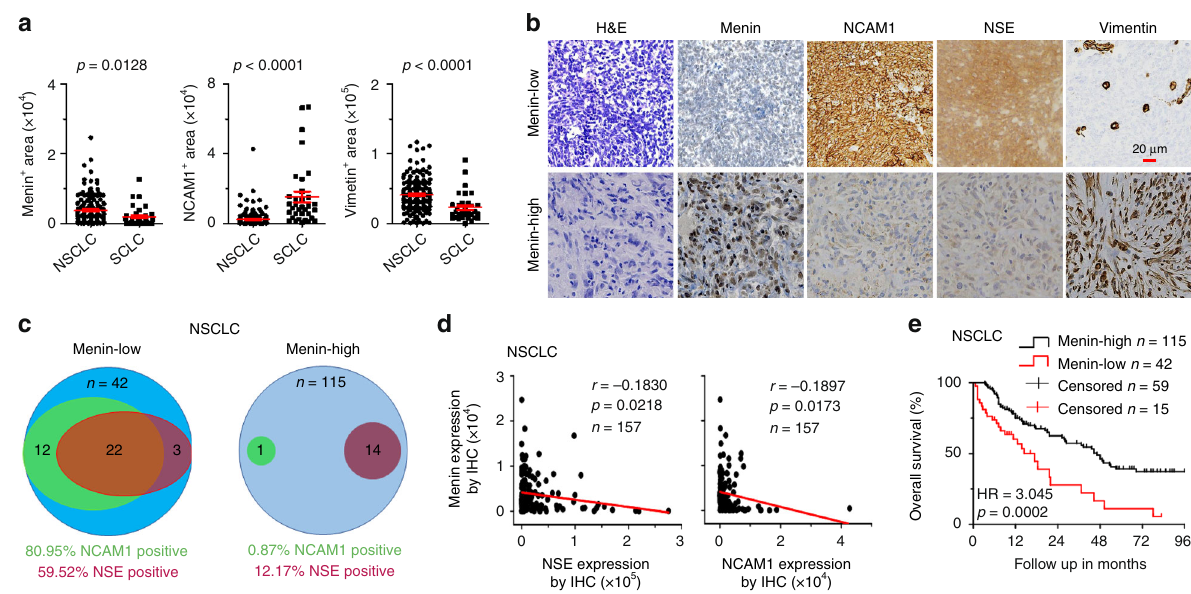
Fig. 6 Menin expression is correlated with poor prognosis and NE differentiation in human primary lung cancer. a Automatic quanti fi cation of menin, NCAM1, vimentin in human NSCLC ( n = 157) and SCLC ( n = 34) specimens IHC staining. b H&E and IHC staining for the indicated proteins in clinical lung cancer samples. High or low indicates that the expression of menin in the tumor was similar to or lower than that in tumor-adjacent tissues, respectively. High, menin + area ≥ 1000; low, menin + area < 1000. Scale bars, 20 μ m. c Venn diagrams show the number of samples with NCAM1 and/or NSE high expression in menin-low and menin-high NSCLC samples. d Correlation analysis between menin and NCAM1 expression, and menin and NSE expression in 157 NSCLC samples. e Kaplan-Meier survival analysis for NSCLC according to menin expression (low, n = 42; high, n = 115; adenocarcinoma: n = 144; adenosquamous carcinoma: n = 13). Data are represented as mean ± SEM in a . Dots in a , d depict individual samples. Signi fi cance determined by two-tailed unpaired t tests in a are indicated. The Spearman correlation and p value by Spearman ’ s test are indicated in d . The Hazard Ratios (HR) and p values by log- rank (Mantel-Cox) test are indicated in e . Source Data are provided as a Source Data fi